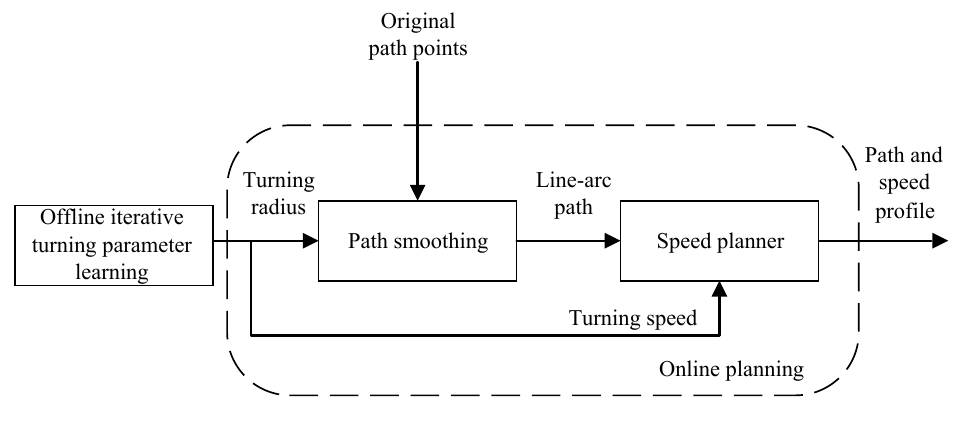
Figure 2. Path and speed-planning